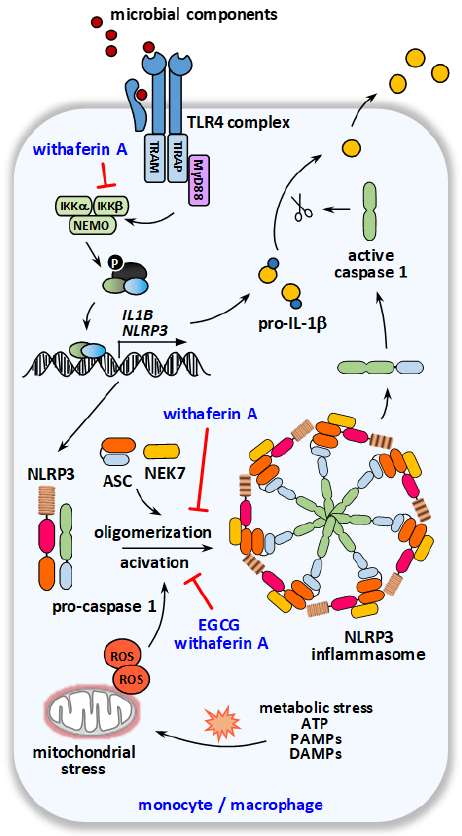
Figure 2. Schematic overview on the molecular targets of EGCG and withaferin A within the IL- 1β pathway . Recognition of microbial components by pattern recognition receptors (priming) on monocytes/macrophages leads to upregulation of NLRP3 inflammasome components and their subsequent oligomerization resulting in NLRP3 inflammasome assembly. As a second signal, e.g. metabolic stress and mitochondrial dysfunction lead to activation of the NLRP3 inflammasome, autoactivation of pro-caspase-1, and thereby enables caspase-1-mediated cleavage of pro-IL- 1β to IL- 1β as its active form.